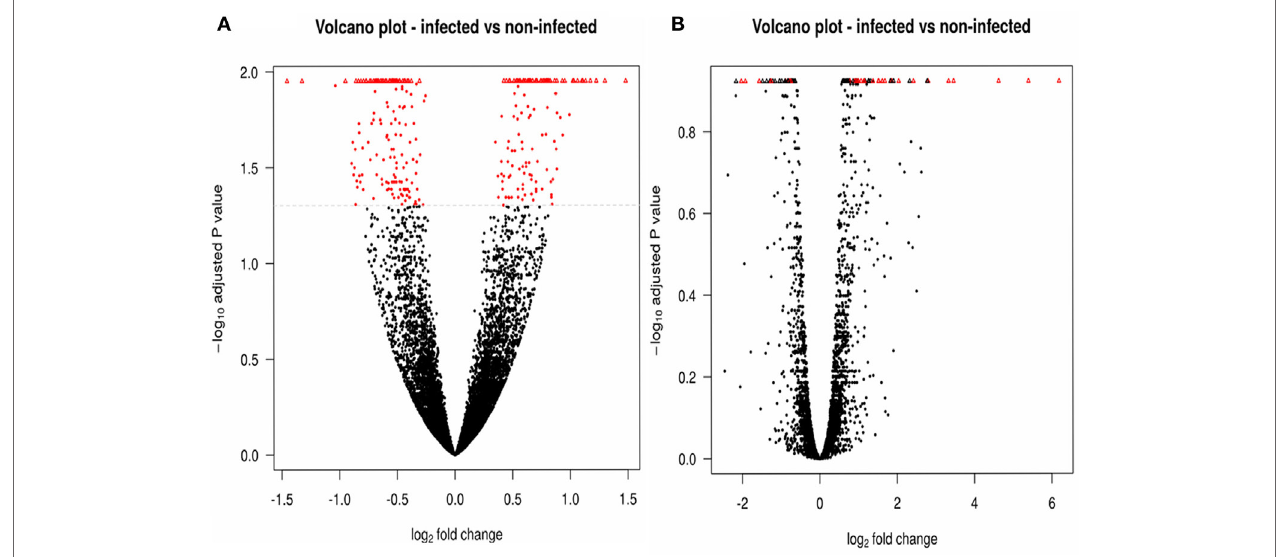
FigUre 2 | Comparisons of significantly differentially expressed genes. DESeq2 (a) and edgeR (b) results are illustrated by volcano plots, in which the differentially expressed features are shown in red. Upregulated genes are thus observed as positive values, and downregulated genes as negative values. Triangles correspond to features where the log of the adjusted p -value is too low or too high to be displayed on the